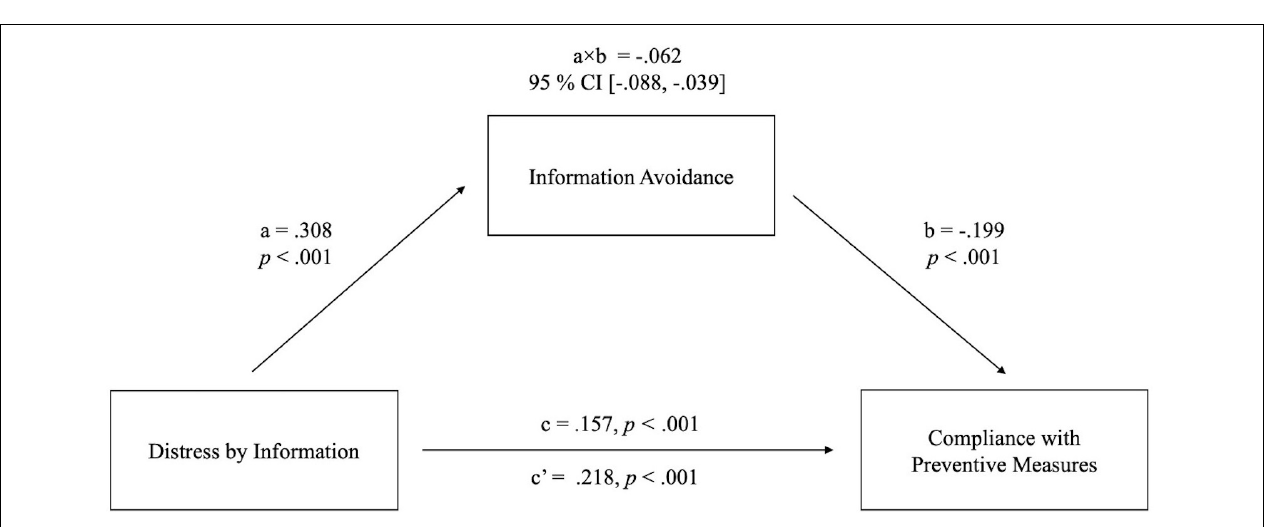
FIGURE 2 | Schematic representation of the mediation model calculated with 5,000 bootstrap samples using PROCESS software. The pathway from distress by information to information avoidance (a) and then to compliance with preventive measures (b) represents the indirect effect of distress by information on compliance with preventive measures, mediated by information avoidance (referred to as a × b path). The path from distress by information to compliance with preventive measures (c’) shows the direct effect. The total effect of distress by information on compliance with preventive measures (c) is also shown on this path. Sociodemographic variables (age, gender, education), anxiety, and eHealth literacy were controlled for in this